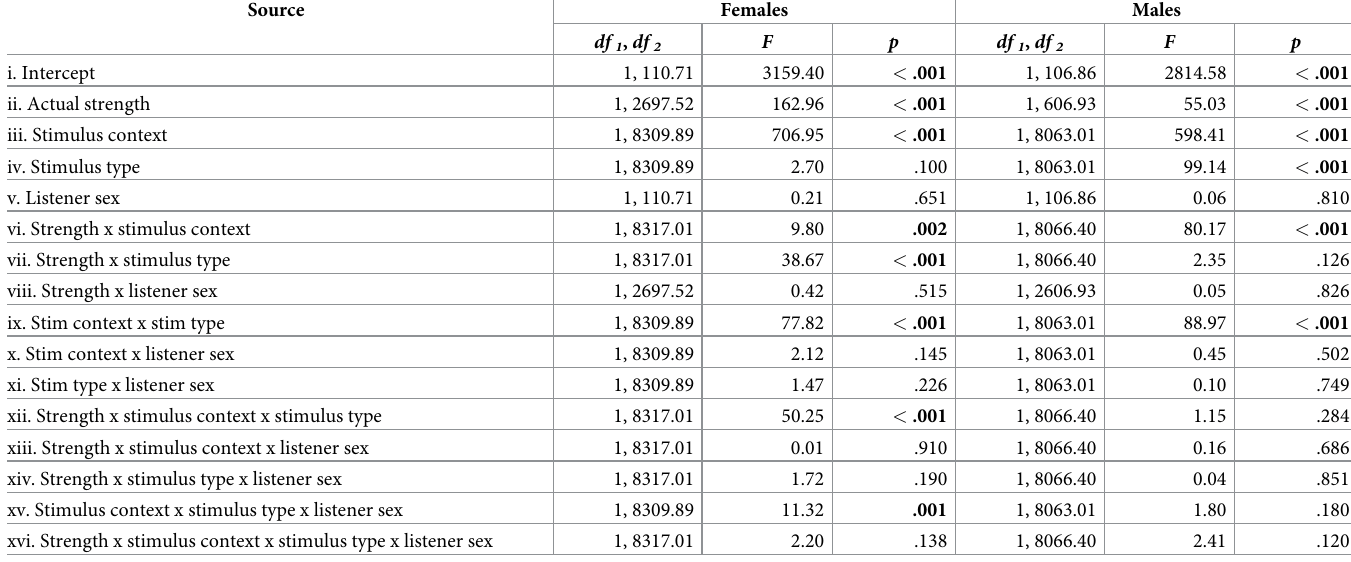
Table 5. Strength estimation: Linear mixed models testing the effects of actual strength, stimulus context, stimulus type, and listener sex on the rated strength of females and males.